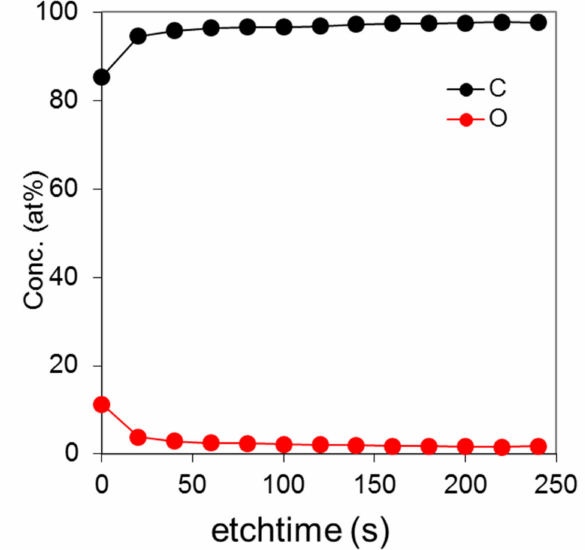
Figure 7. XPS depth profile of the diamond tip subsequent to sliding against